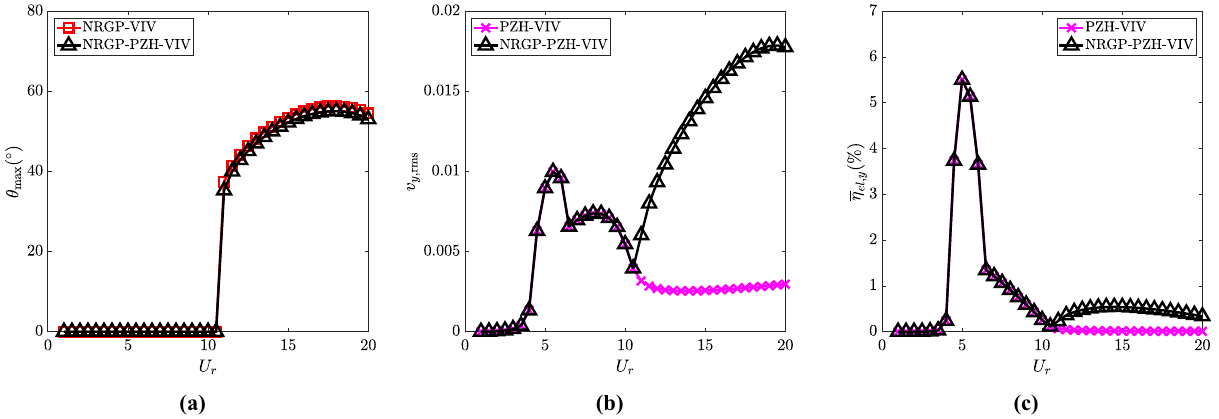
Figure 3. Effect of the introduction of NRGP with U r on: ( a ) maximum angular rotation of the pendulum θ max in degrees ( ◦ ) , ( b ) electric tension v y ,rms , and ( c ) energy harvesting efficiency η el , y . For the NRGP cases, m = 0.3 , l d = 0.1 , ω r = 1.3 and ζ θ = 0.0011